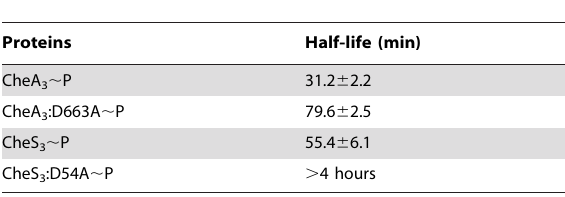
Table 1. Half-lives of phospho-HHKs.